Question: Give a one-sentence summary of this figure.
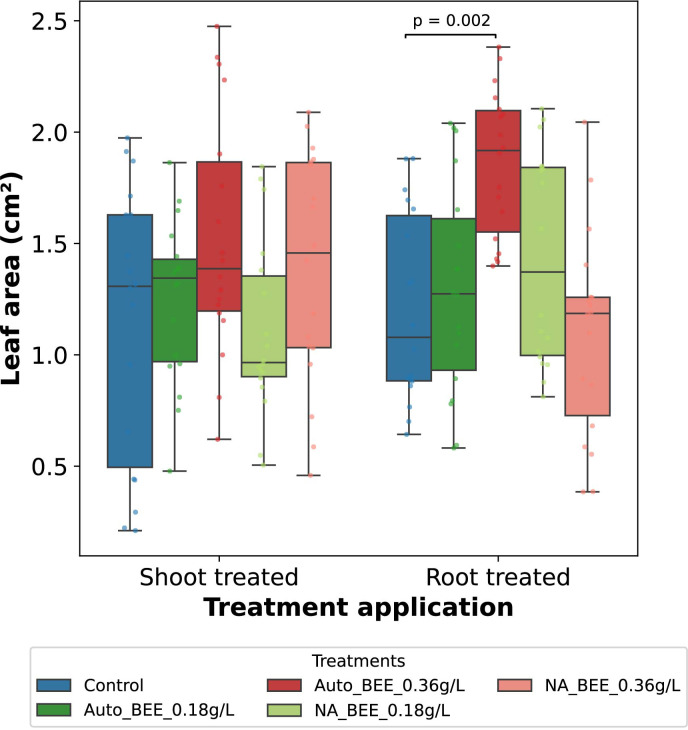
Answer: Effect of different forms of BEE and different application methods on Arabidopsis leaf area. The data represent 18 technical replicates per bar. Data are presented in a boxplot with all data points and bars indicating the minimum and maximum values. Statistical significance (n = 18, p < 0.05) between control and treatment BEE in respective groups (application) are shown and determined using two-way ANOVA followed by Tukey’s HSD test. Auto_BEE, autoclaved Belgian endive extract; NA_BEE, non-autoclaved Belgian endive extract.